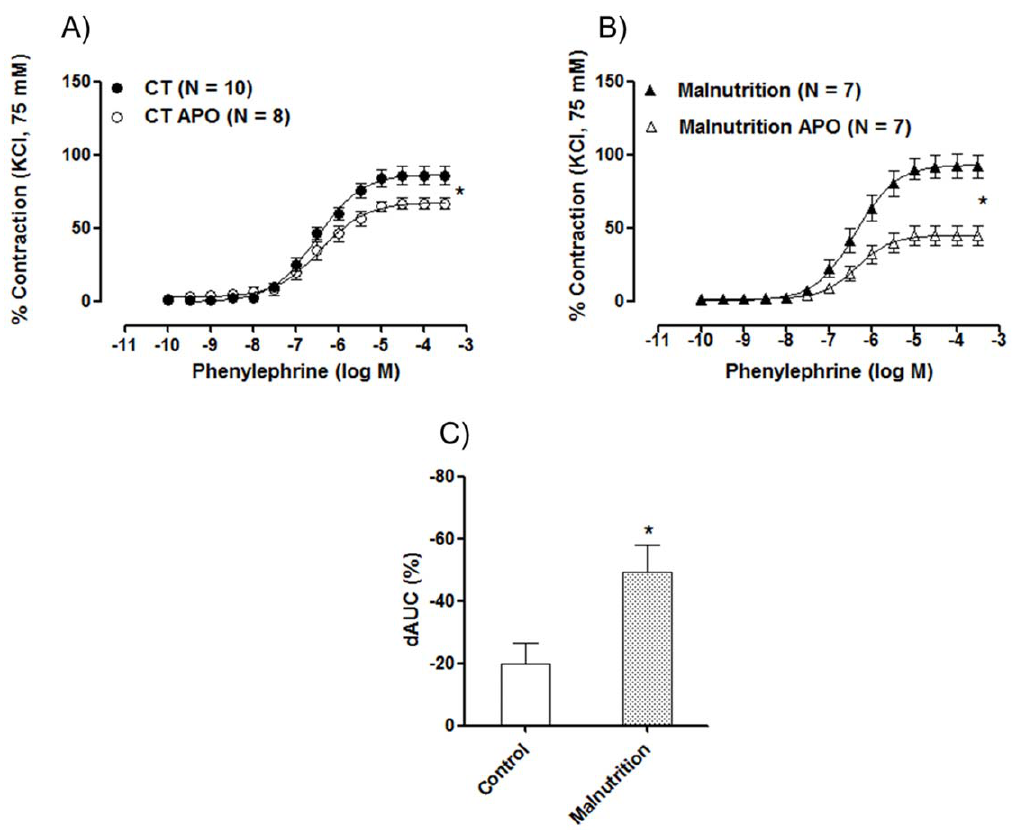
Figure 4. Concentration-response curve to phenylephrine in isolated aortic rings from (A) control (CT) and (B) post-weaning protein malnutrition (Malnutrition) rats before (E + ) and after incubation with apocynin (APO). C) Comparison of the percent difference of the area under the curve (% dAUC) in vessels in presence or absence of apocynin from control (CT) and post-weaning protein malnutrition (Malnutrition) rats. The number of preparations is indicated in parenthesis. The results are expressed as the means 6 SEM. * P , 0.05 for R max : CT E + vs. CT APO; R max : Malnutrition E + vs. Malnutrition + APO and dAUC% CT vs. Malnutrition by Student’s t -test.